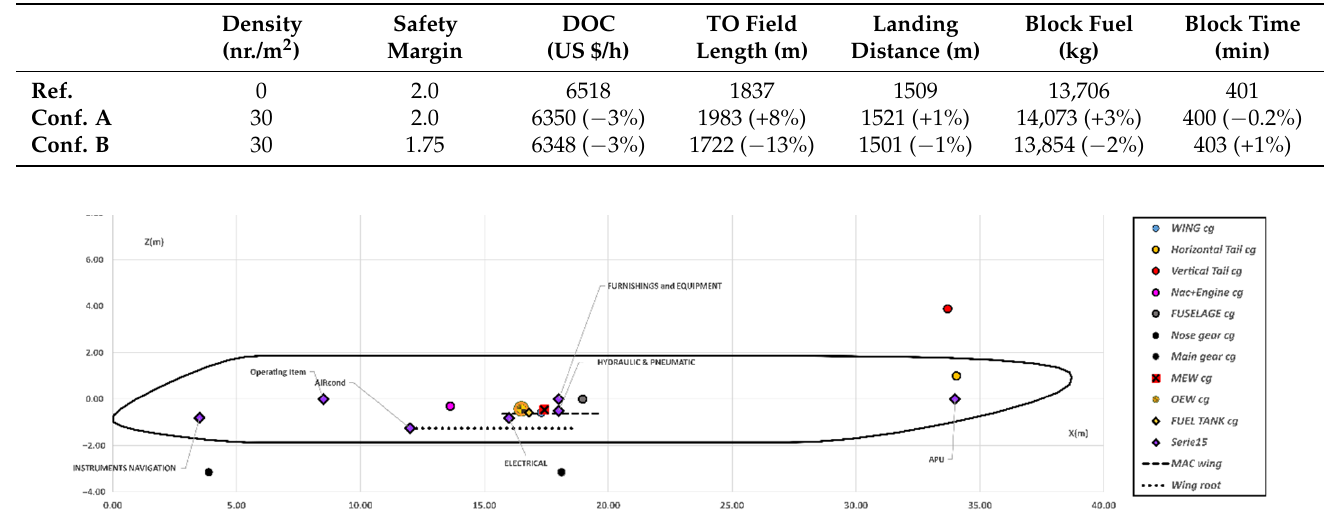
with SHM, but with SM = 2).